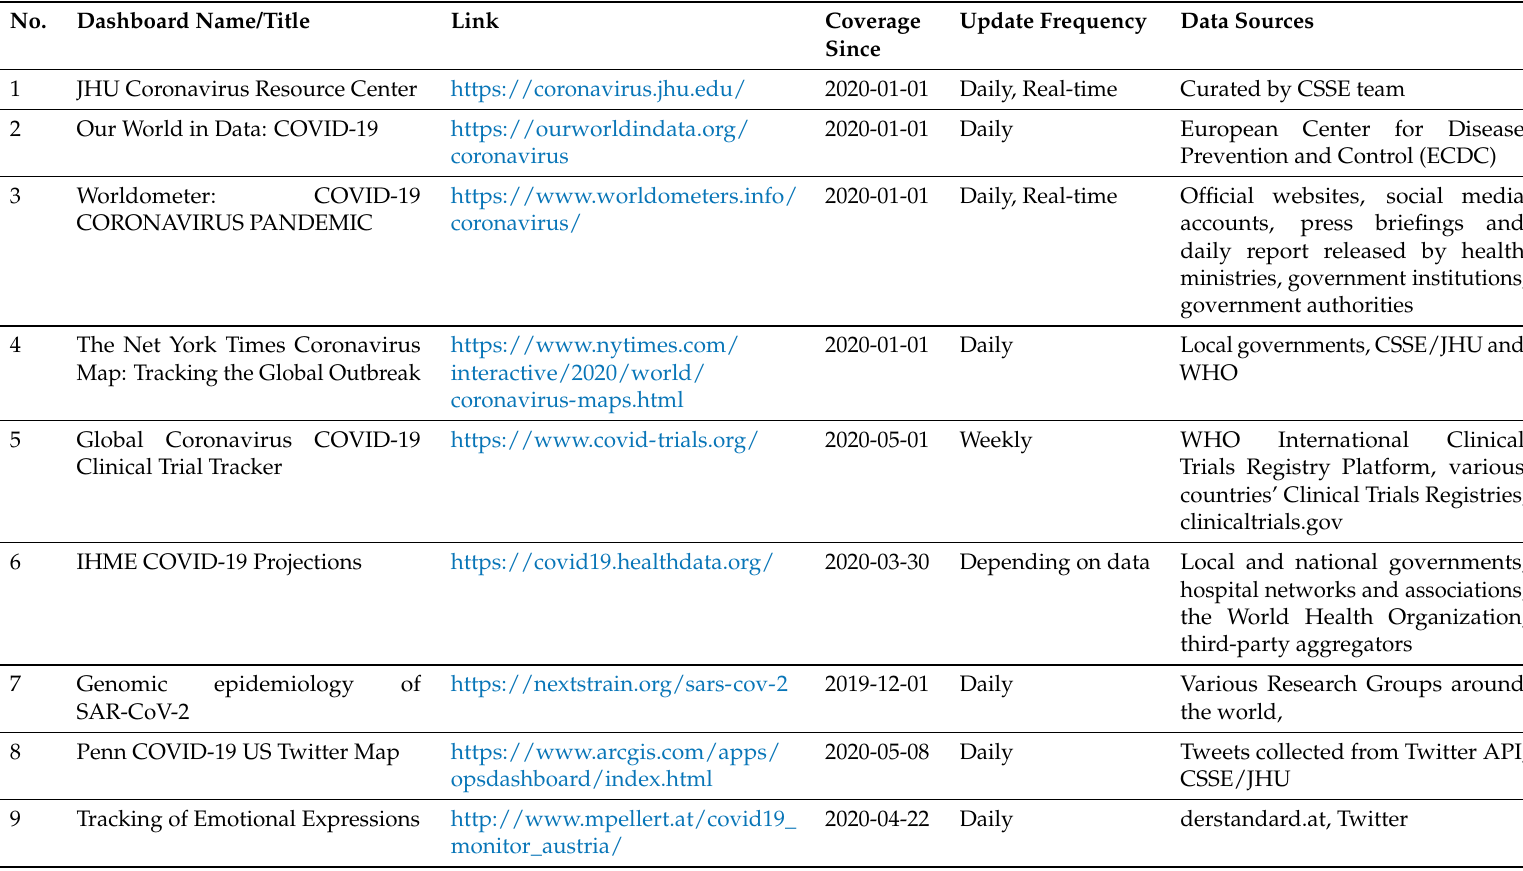
Table 4. Analysis of COVID-19 dashboards and epidemiological models using selected features (Part 1 of 2).